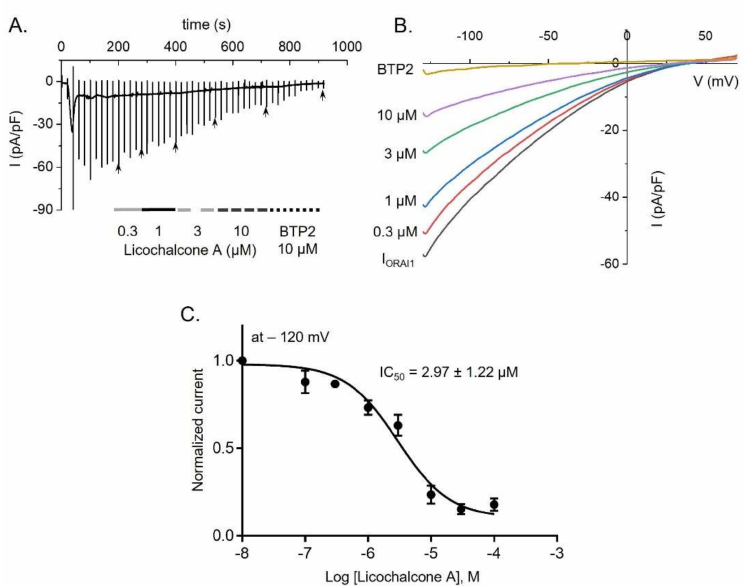
Figure 1. Inhibition of ORAI1 currents (I ORAI1 ) by licochalcone A in HEK293T cells overexpressing hORAI1 and hSTIM1. ( A ) A representative current trace indicates the suppressive effect of different concentrations of licochalcone A and BTP2 on I ORAI1 . ( B ) Current (I)-voltage (V) relationship of I ORAI1 in the cells with or without treatment with licochalcone A. ( C ) Concentration-response image of licochalcone A suppression on I ORAI1 , which was statistically analyzed at − 120 mV. Data are presented as means ± SEM ( n = 4–7 per